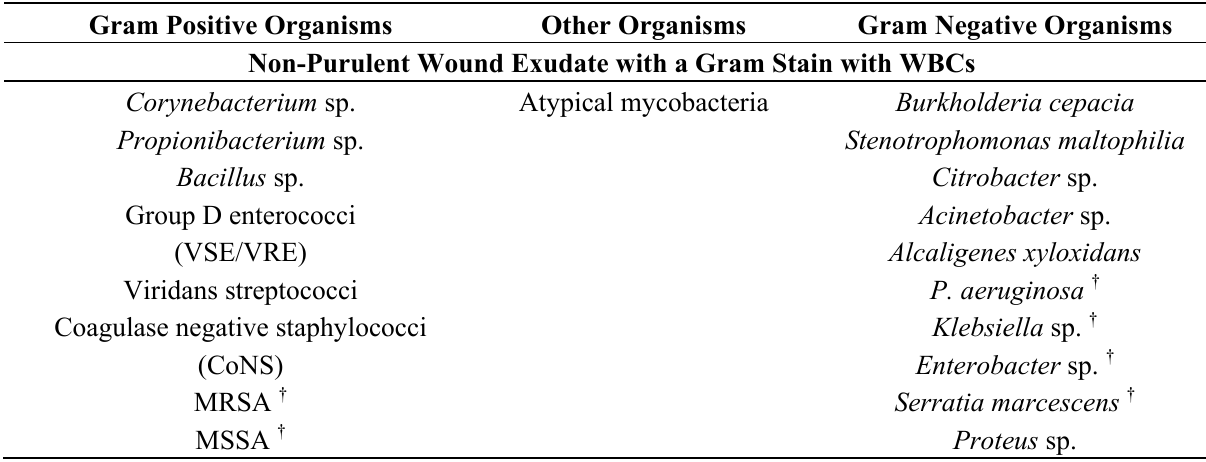
Table 4. Skin/Wound organisms that should be considered as commensals/colonizers †